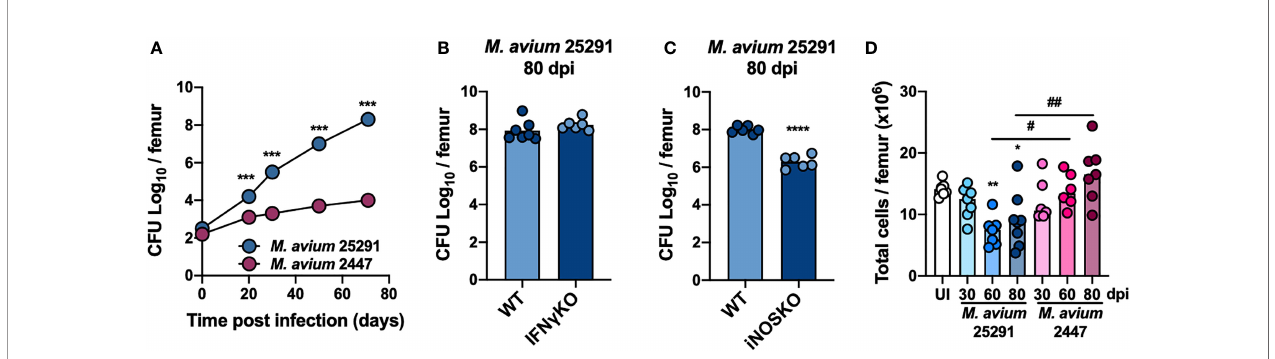
FIGURE 1 | Bacteria load in the BM is higher after infection with M. avium strain 25291 than with strain 2447. (A) Representative kinetics of M. avium infection in the BM of WT mice infected with strains 25291 (blue) or 2447 (pink). (B, C) Bacterial load in the BM from WT, IFN g KO and iNOSKO mice infected with M. avium strain 25291 for 80 days. At each time-point of infection, groups were compared by two-tailed unpaired t -test and were marked as: *** p < 0.001; **** p < 0.0001. (D) Total number of BM cells per femur of uninfected WT mice (white), or after infection with M. avium strain 25291 (blue) or strain 2447 (pink) at 30, 60 and 80 dpi. The groups of infected mice, at the several time-points, were compared with the uninfected mice by ordinary one-way ANOVA followed by Dunnett ’ s multiple comparisons test and were marked as: * p < 0.05; ** p < 0.01; comparisons between infected groups were performed by 2-way ANOVA followed by Tukey ’ s multiple comparisons test, and marked as: # p < 0.05, ## p < 0.01. Data represent the mean ± SD (A) or mean (B – D) from 5 to 8 mice per group, from one of two independent experiments. UI stands for uninfected. dpi stands for days post